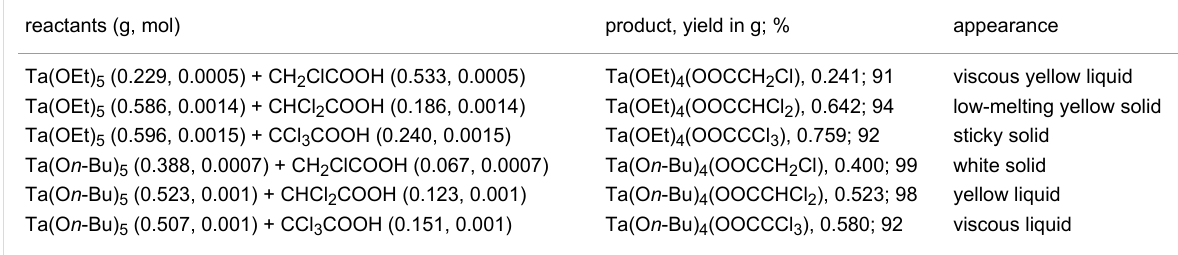
Table 1: Preparative details and physical properties of tantalum alkoxy carboxylates. reactants (g, mol) product, yield in g;